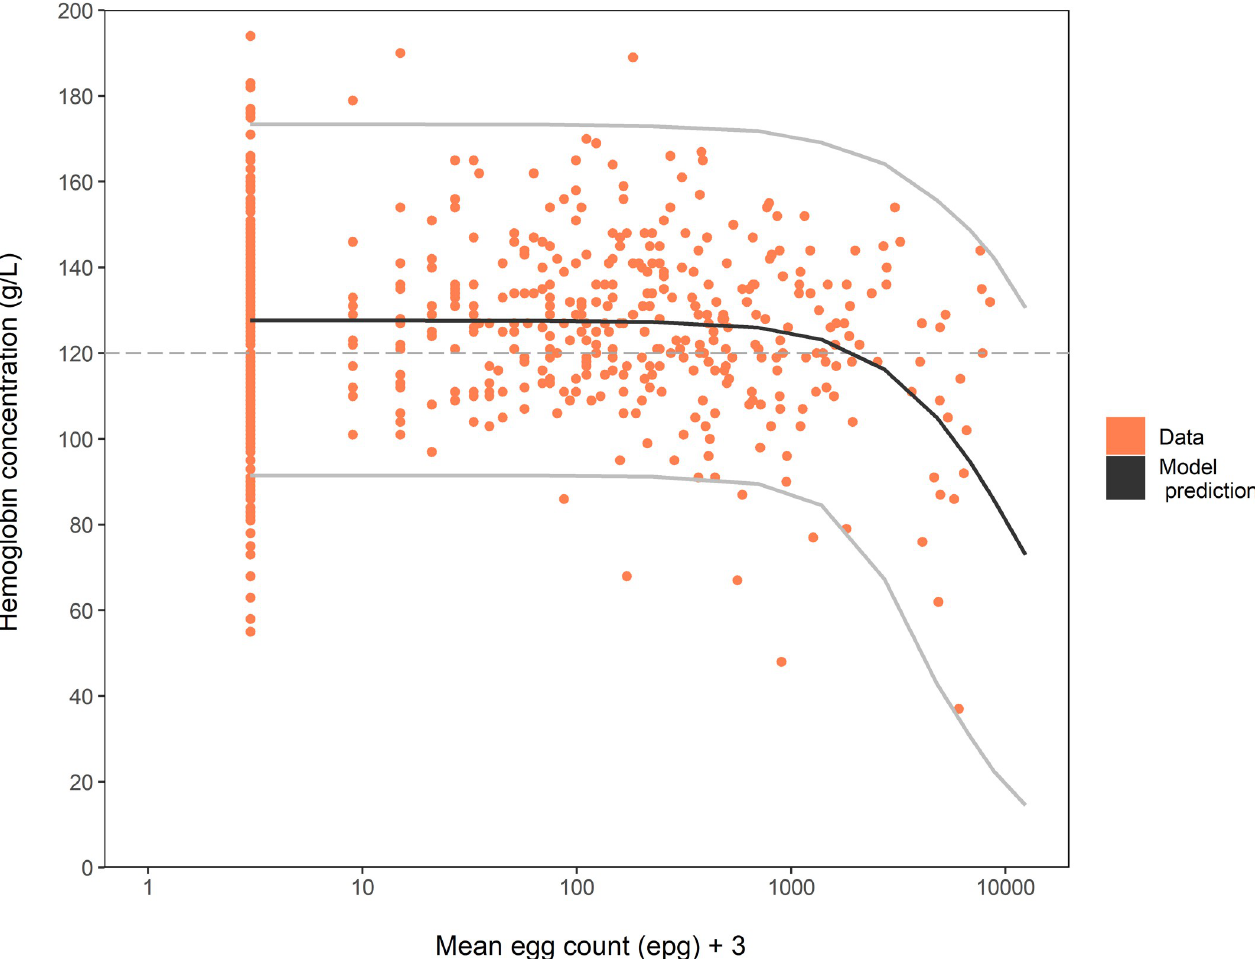
Fig 2. Relationship between individual haemoglobin concentrations (g/L) and mean egg count (epg). Orange bullets represent observed individual data used for model fit. The joint posterior predictive distribution of Hb and mean egg count based on 20,000 replications is displayed through the mean of the Hb predictions (y-axis) and the geometric mean of egg count predictions (x-axis) (black line). Mean egg count data are shifted of +3 epg (i.e. half of the detection limit) to display the zero counts on the logarithmic-scaled axes. The 95% Bayesian Credible Interval (light grey lines) is shown for the marginal Hb posterior predictive distribution. The WHO threshold defining anaemia used in the model is displayed as horizontal dashed